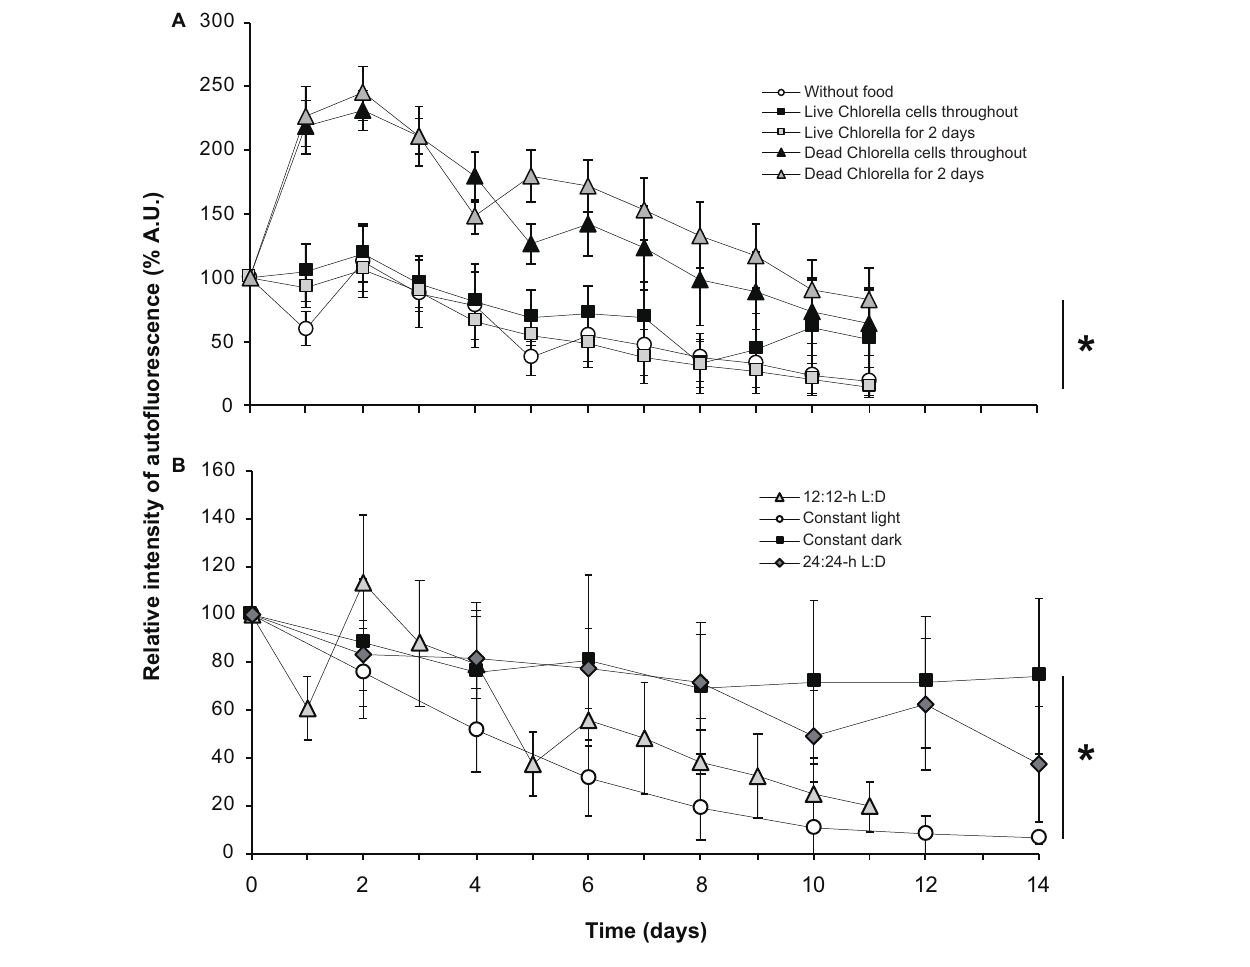
FIGURE 5 | Relative intensity of autofluorescence. (A) Fluctuation of autofluorescence according to the food source provided (or not). (B) Fluctuation of autofluorescence according to the light condition used. D, dark; L, light. An asterisk denotes significant differences between each condition in average values with ± standard deviation at * p < 0.05, two-way ANOVA.